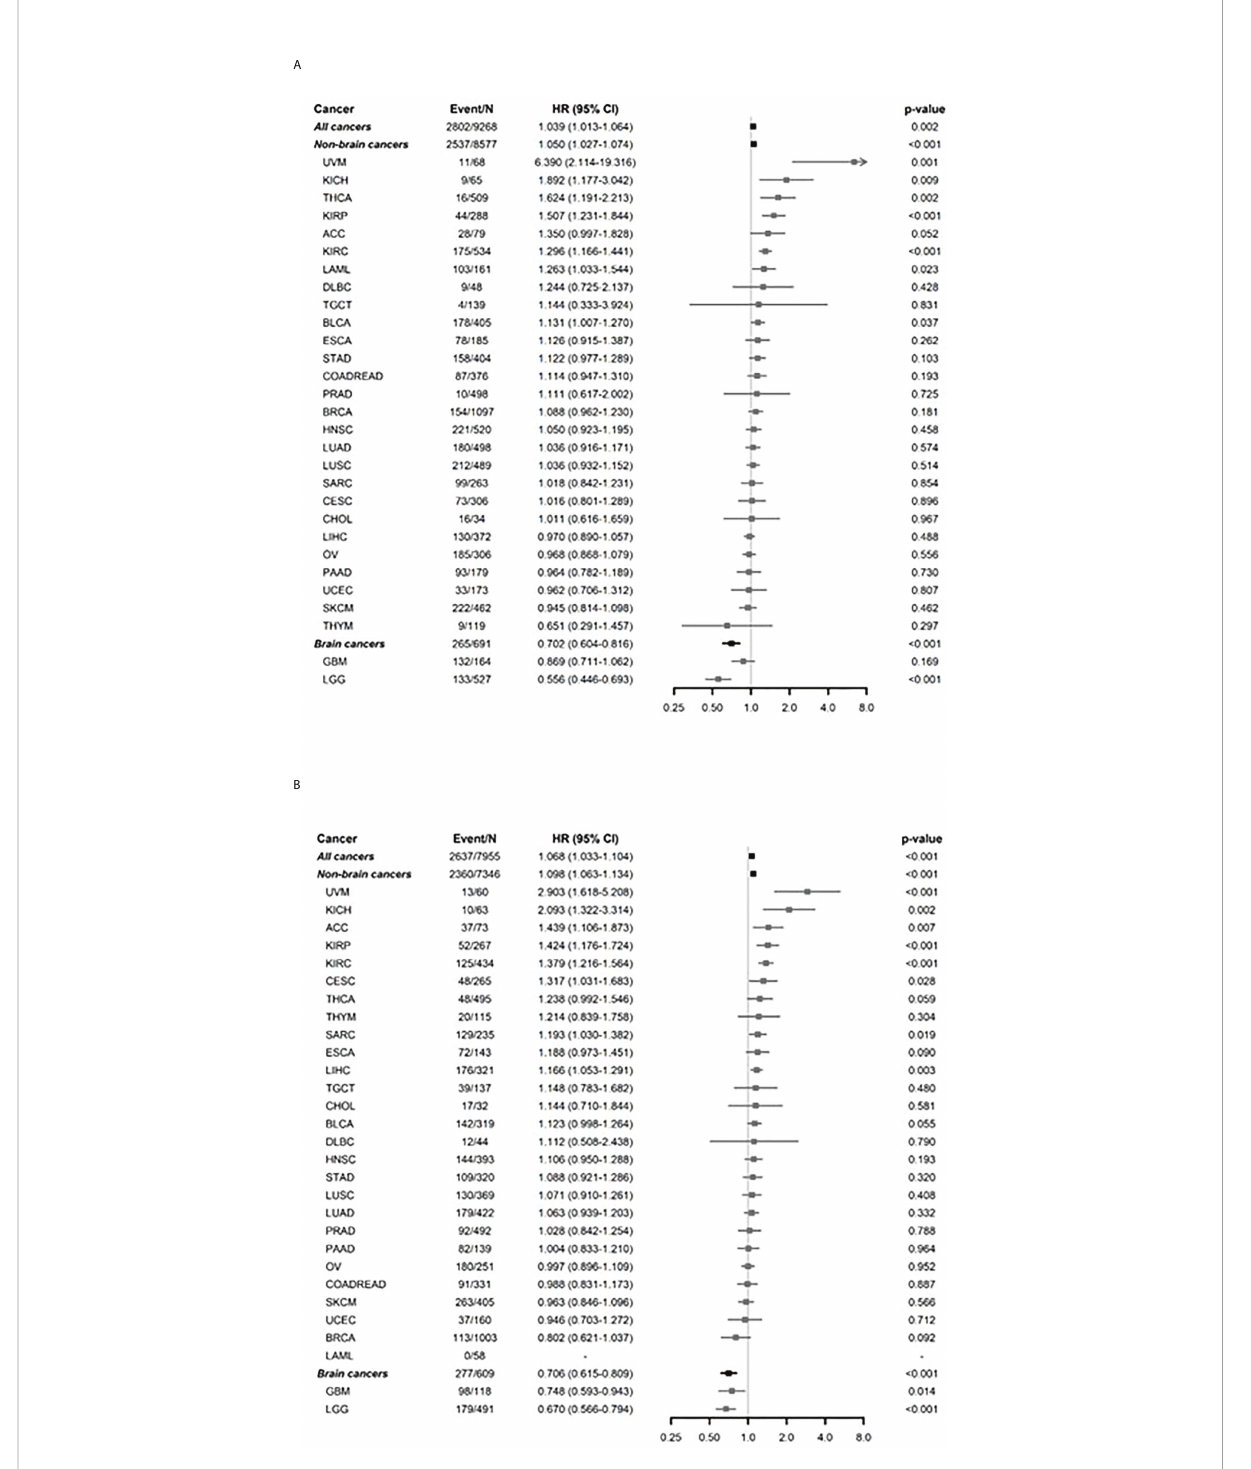
FIGURE 1 Subgroup analysis by each of cancer types for FADS1 on survival. (A) overall survival (OS) after adjusting age and race. (B) Disease free survival (DFS) after adjusting age and race. ‘ Non-brain cancers ’ and ‘ Brain cancers ’ show the overall summaries for non-brain cancer types and brain cancer types (such as GBM and LGG), respectively. The hazard ratios (HRs) and 95% con fi dence intervals (CIs) were estimated using multivariable Cox regression analyses between OS and continuous expression levels of FADS1 after adjusting age and race. The HRs and 95% CIs of ‘ All cancers ’ , ‘ Non-brain cancers ’ , and ‘ Brain cancers ’ were estimated using mixed-effects Cox regression models to account for the effect of different cancer types. The x-axis represents